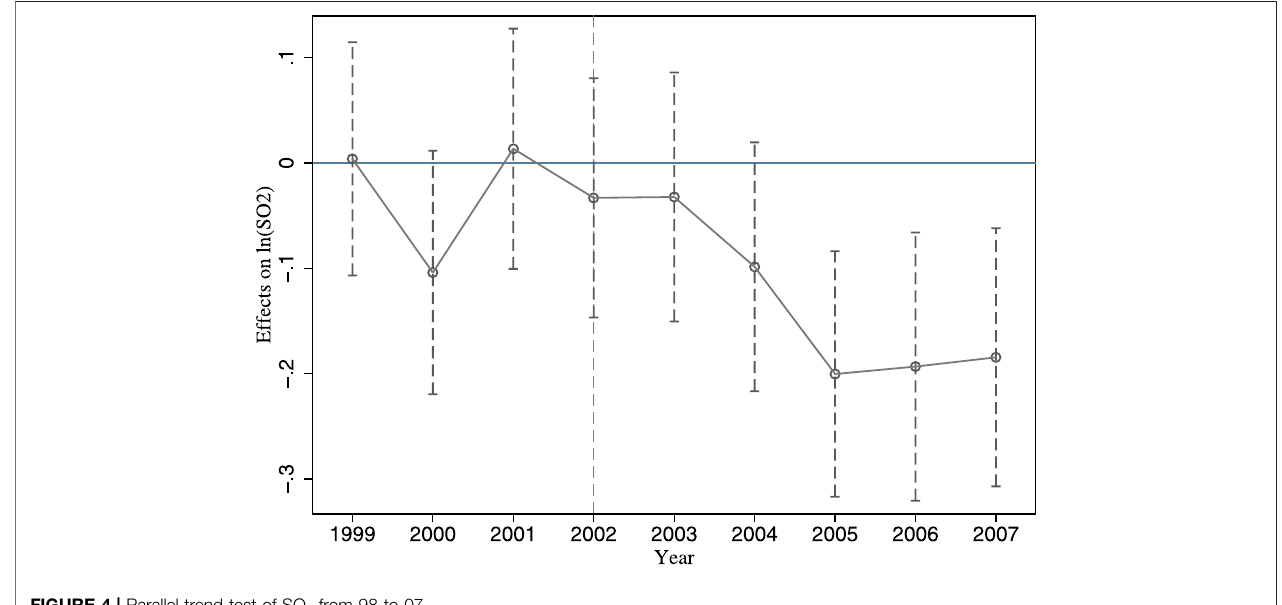
FIGURE 4 | Parallel trend test of SO 2 from 98 to 07.